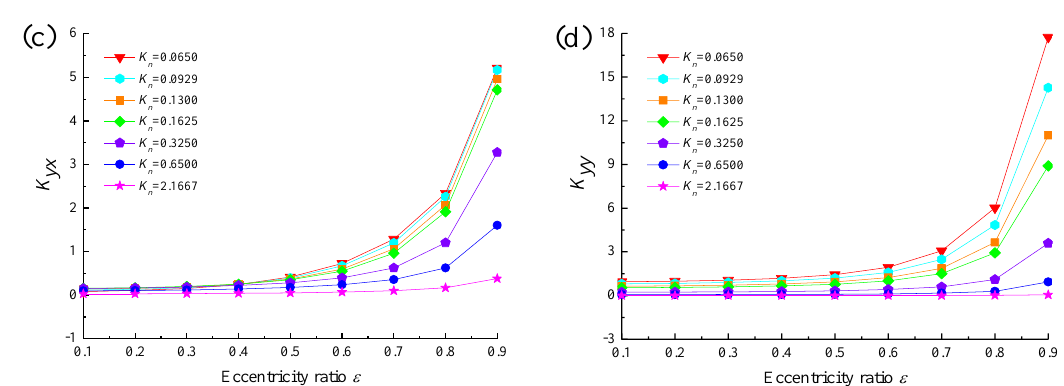
Figure 11. Dynamic stiffness coefficients of Boltzmann model plotted as function of eccentricity ratio for various Knudsen numbers. ( a ) K xx vs. ε ; ( b ) K xy vs. ε ; ( c ) K yx vs. ε ; ( d ) K yy vs. ε.